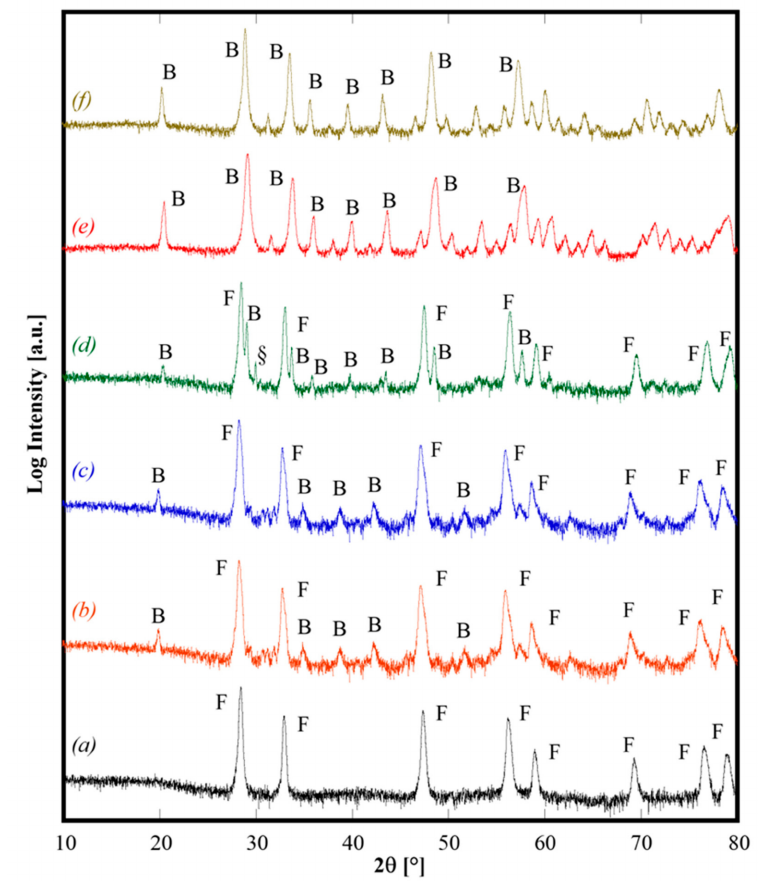
Figure 2. Di ff raction patterns of CeZrYLaGd-N (pattern a ), CeZrYLaGd-U (pattern b ), CeZrYbLaGd-U (pattern c ), CeZrYbLaEr-U (pattern d ), CeZrYYbEr-U (pattern e ), CeZrYbErGd-U (pattern f ) annealed at 1500 ◦ C for 1 h and air quenched from 1200 ◦ C. F, B and § label fluorite structure, bixbyite structure and the unknown phase,